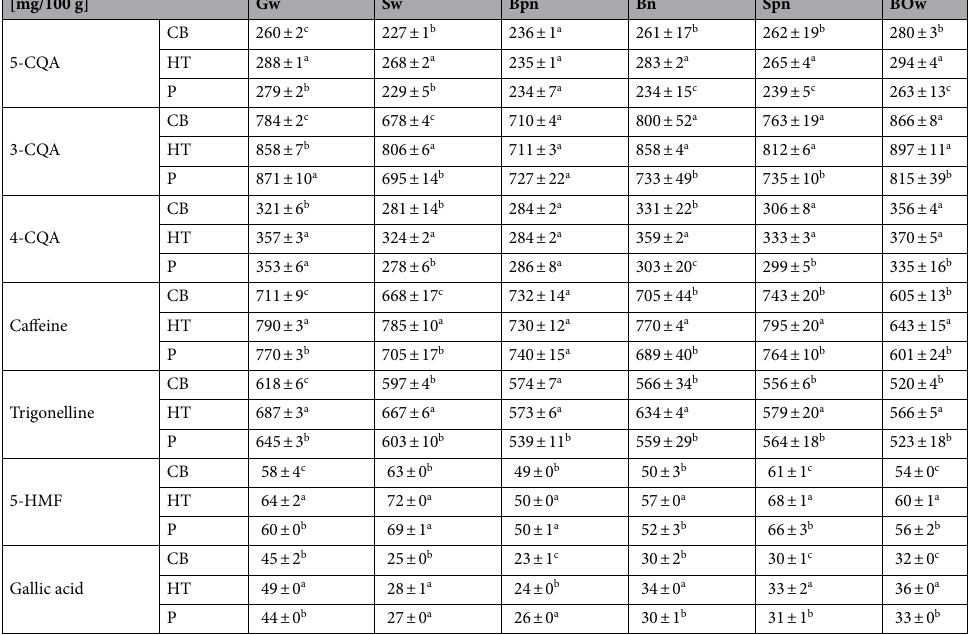
Table 1. The level of identified chemical compounds (mg/100 g) in coffee brews. The values represent average ± standard deviation, n = 6. 3-CQA 3-O-caffeoylquinic acid, 4-CQA 4-O-caffeoylquinic acid,